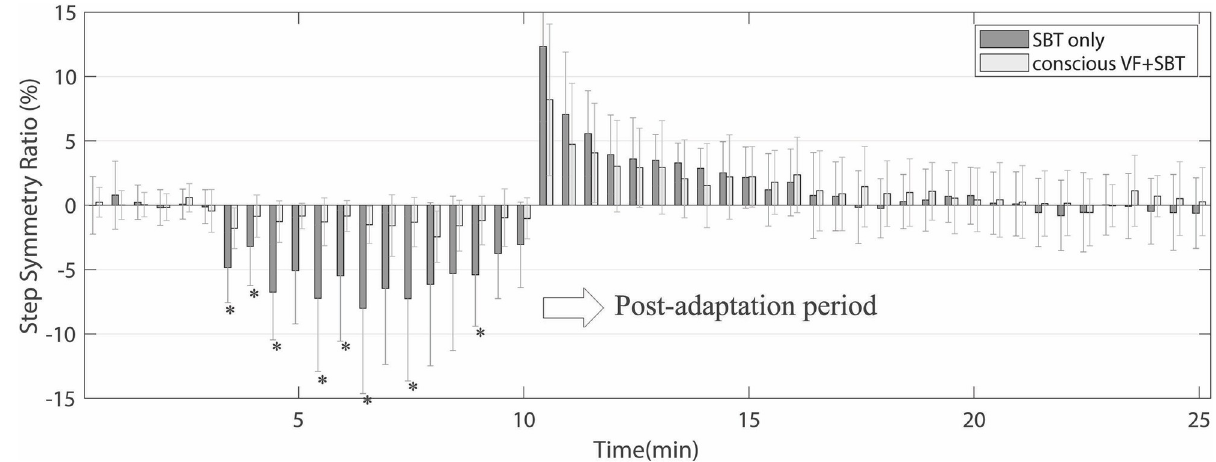
Fig 4. Changes in the mean step length symmetry averaged across 12 subjects during the conscious VF+SBT and the SBT-only conditions. The asterisks ( � ) were marked at time periods, where the induced step length symmetry values were significantly different between two conditions (p < 0.05).